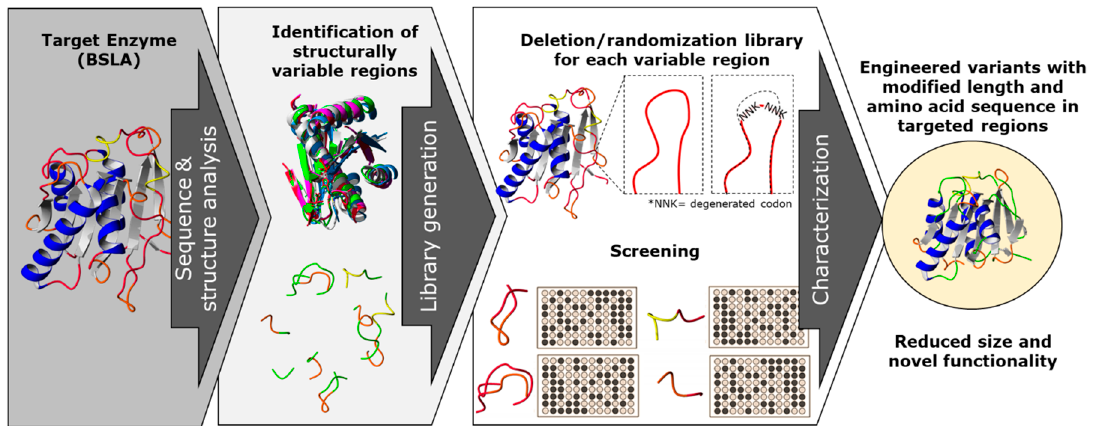
Figure 1. A combination of rational and random mutagenesis approaches is proposed to achieve targeted and simultaneous variation on protein sequence length and amino acid residues. With the premise that reducing the sequence size of enzymes leads to a “overall size optimization” process, we aim to identify and target structurally non-conserved regions of the protein (variable in sequence and size) for a deletion/randomization process. The targeted sequences are subjected to deletion of two amino acid residues, and the new junction will be randomized as an NNK codon for each joining residue in order to allow the new junction to find a new stable amino acid pair, generating a double site saturation mutagenesis library for each targeted region. This strategy offers a unique combination of sequence deletion and randomization by generating a novel type of diversity to be screened and generating enzyme variants which have probably not yet been described.